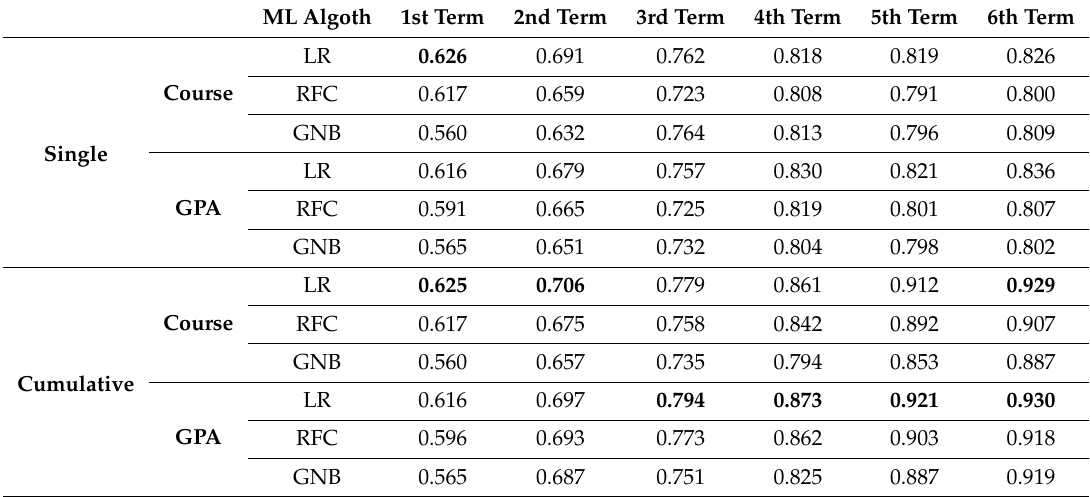
Table 9. Accuracy results of the ML Models with the academic, demographic, and pre-college features. ML Algoth 1st Term 2nd Term 3rd